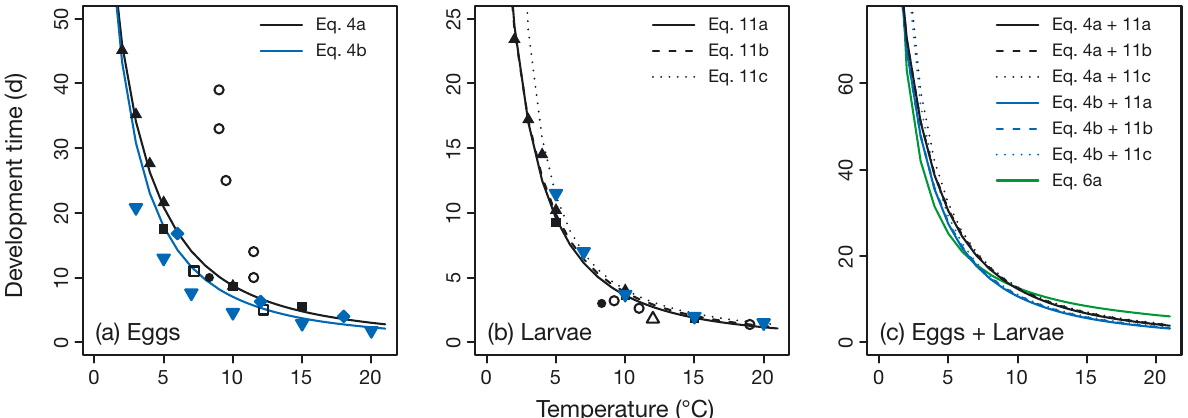
Fig. 3. (a) Egg development times of salmon lice from S Johannessen (1977), J Johnson & Albright (1991), M Boxaspen & Næss (2000), H Heuch et al. (2000), ● Tucker et al. (2002), Z Samsing et al. (2016, Table S1) and R Hamre et al. (2019, Table 5). Black filled symbols ( JM ● ) represent data used by Stien et al. (2005) to calculate Eq. (4a); all filled symbols ( JM ● ZR ) represent data used to calculate the updated Eq. (4b). Lines show egg development time as a function of temperature according to Eqs. (4a) or (4b). (b) Larval development times. S , J , M , ● and Z refer to the same data sources as in (a), with Δ from Wootten et al. (1982). Lines show larval development time as function of temperature according to Eq. (11a) (Stien et al. 2005), Eq. (11b) (re- estimated based on all the plotted data, not easily distinguishable from the line for Eq. 11a), or Eq. (11c) (Samsing et al. 2016). (c) Lines show total egg and larval egg developmental times calculated by combining the equations for eggs and larvae, or approximated by a total development time of 126 degree-days (as assumed in the baseline model; Eq.